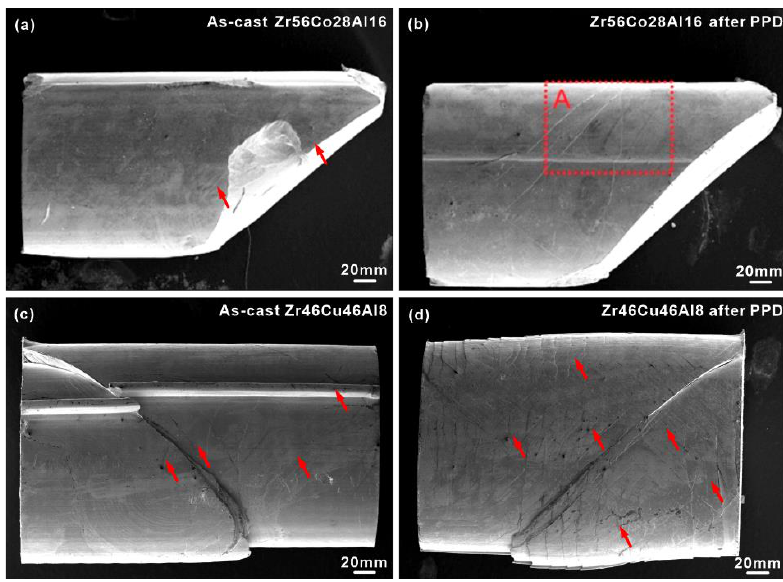
Figure 4. Fracture morphologies of the ( a , b ) Zr 46 Cu 46 Al 8 and ( c , d ) Zr 56 Co 28 Al 16 BMGs in the as-cast state and after PPD treatments; the solid arrows and dotted square A represent shear bands and the regions where shear bands exist.